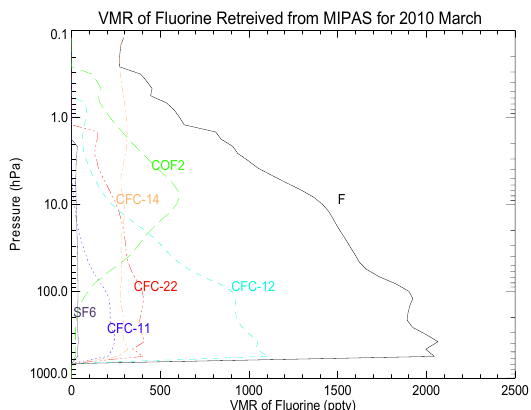
Fig. 3 , The vertical profiles of all the fluorine containing species and the total fluorine retrieved by